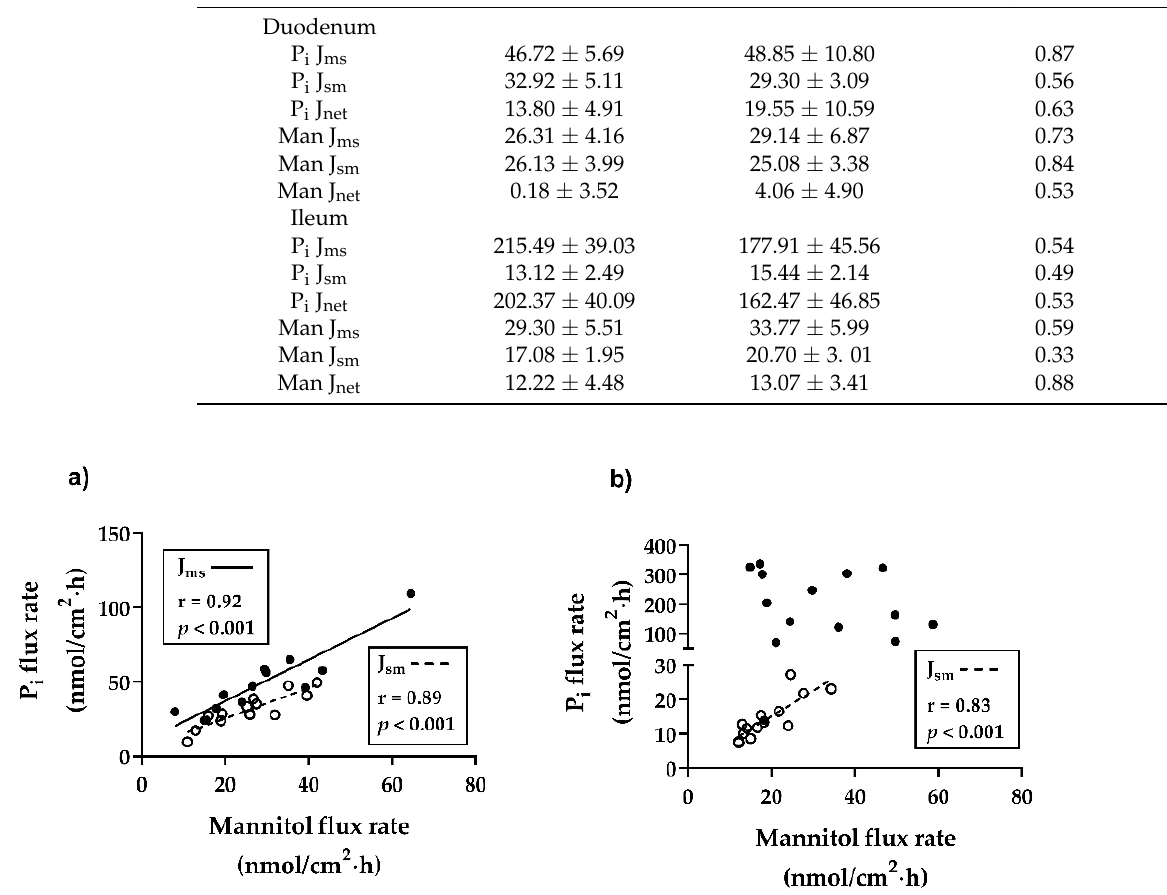
Table 4. Inorganic phosphate (P i ) and mannitol (Man) flux rates of duodenal and ileal epithelia of young goats fed a low phosphorus (P) diet. (Mean values with their standard errors; n = 7 animals.) Items Control